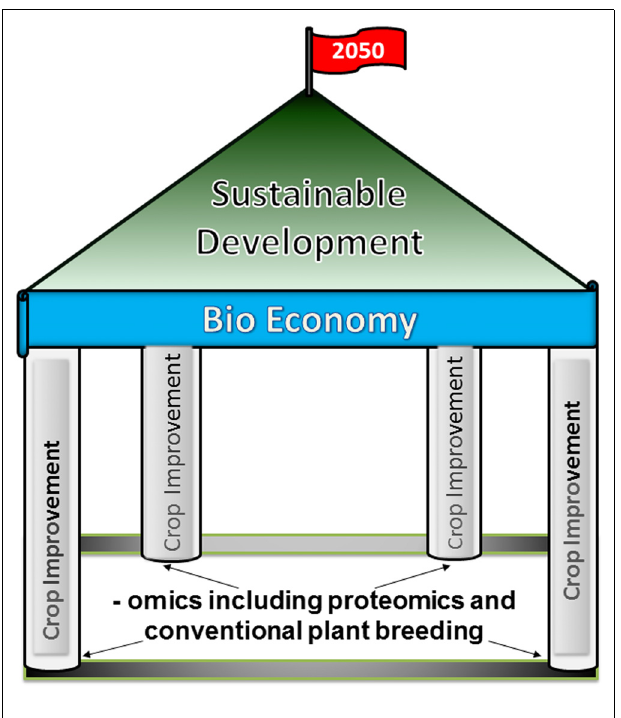
FIGURE 1 |An illustration showing that the -omics and the conventional plant breeding techniques are the pillars of bio-economy, and a strong bio-economy is the foundation of sustainable development of a society. By the incorporation of these technologies for crop improvements, the bio-economy is uplifted and thus, we should be able to reach our strategic goals set for the agricultural productions by the year